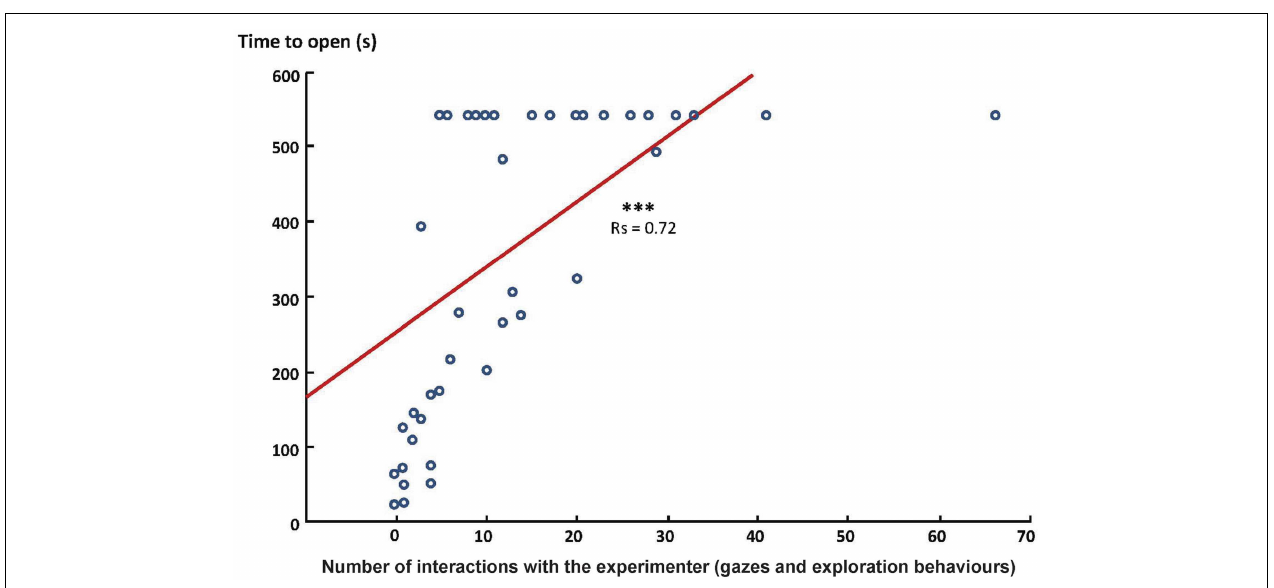
FIGURE 2 | Correlation between the interest of the horse toward the experimenter and the time required to open the chest (Spearman correlation test, *** p < 0.001). Data are represented in number of behaviors and time (s) required to open the chest.